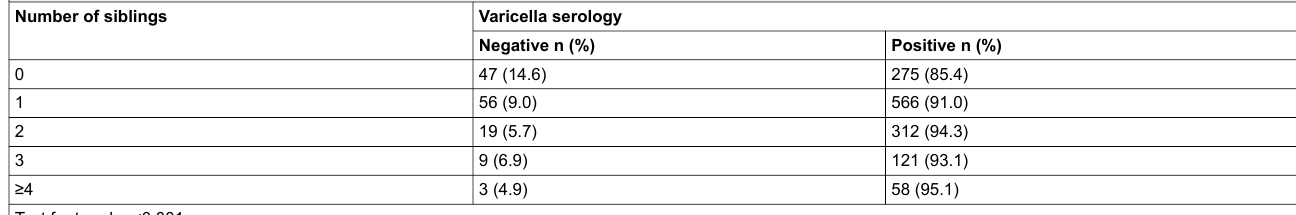
Table 1: Results of varicella serology according to number of siblings in travellers seeking pre-travel advice at the Travel Clinic of the University of Zurich between December 2008 and August 2015 who had an uncertain or negative varicella history (n = 1757). Varicella serologyNumber of